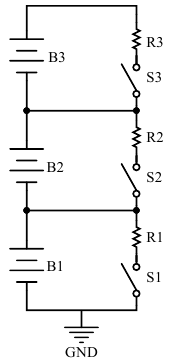
Figure 1. Switched shunt resistor balancing